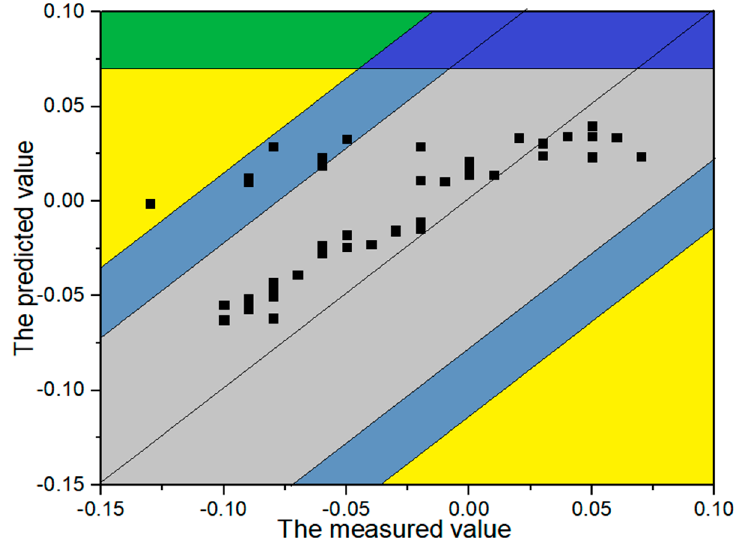
Figure 9. The risk gradation for the evaluation indexes at the first period. Table 3. The statistical number of the five evaluation indexes at the first period.